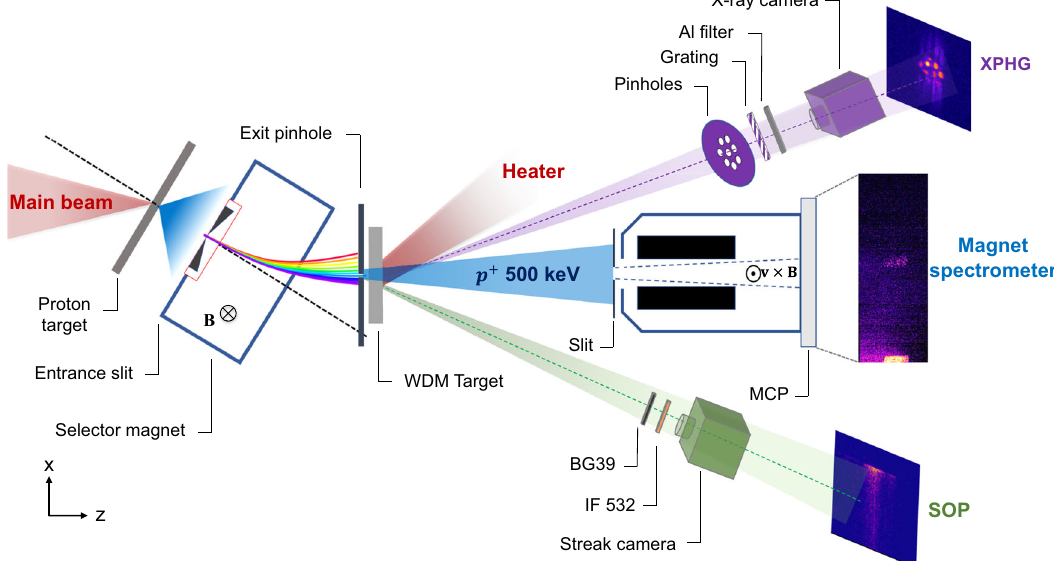
Fig. 2 Experimental setup. Scheme of the experimental setup for each shot: (i) selection of a 500 keV energy proton beam from an initial broadband TNSA spectrum generated by the main beam, (ii) WDM sample generation by the heater beam, (iii) measurement of the downshifted proton energy spectrum of the selected beam after passing through the WDM target and (iv) characterization of the WDM sample by the SOP and the XPHG diagnostics. Typical raw experimental data acquired for each shot are shown for the magnet spectrometer as well as for the SOP and the XPHG diagnostics.